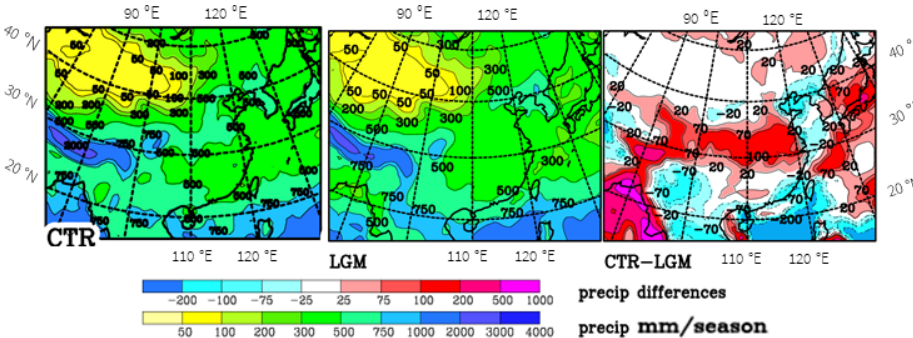
Figure 5. Summer (JJA) precipitation simulated for eastern Asia and differences between CTR and LGM. Units: millimetres per